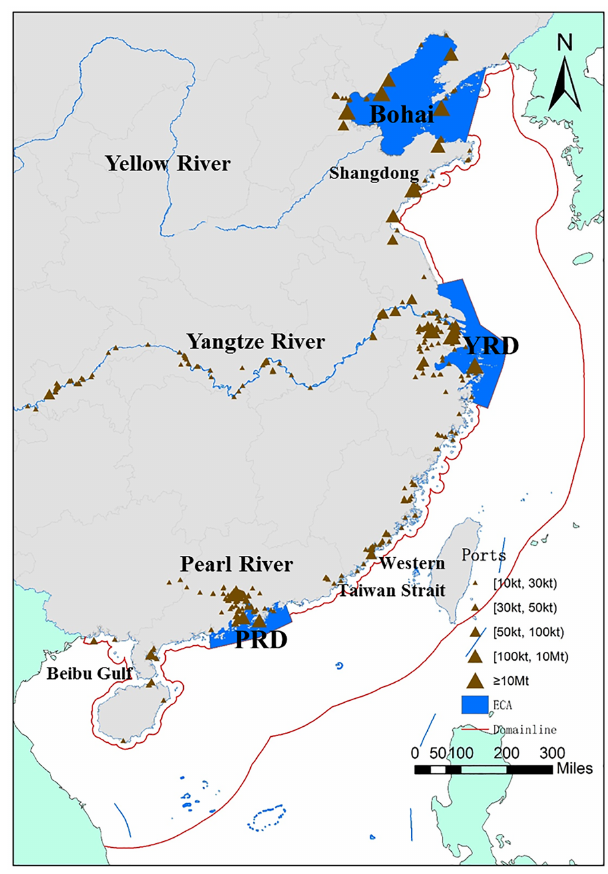
Figure 1. The location of the research domain, port groups and DECAs in this